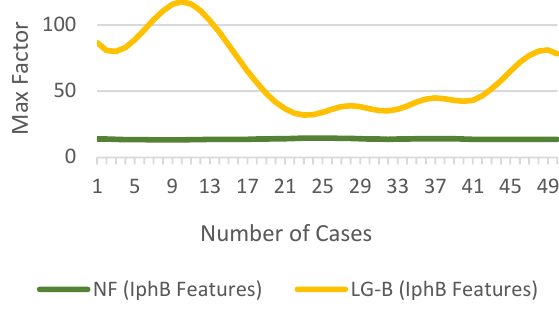
Figure 11. MF of Iph B for NF and fault